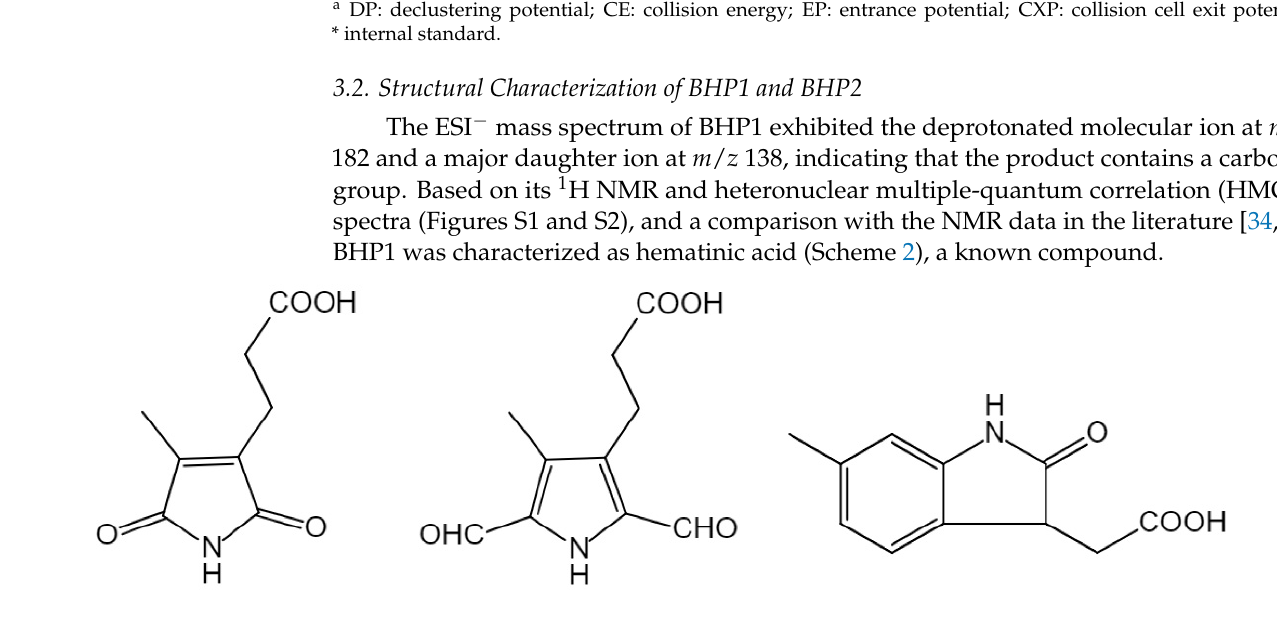
Products 8 (BHP2) 4.4